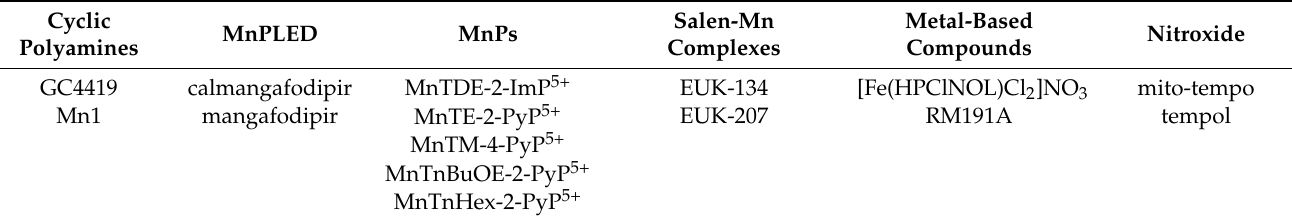
Table 5. A proposed SOD mimetic